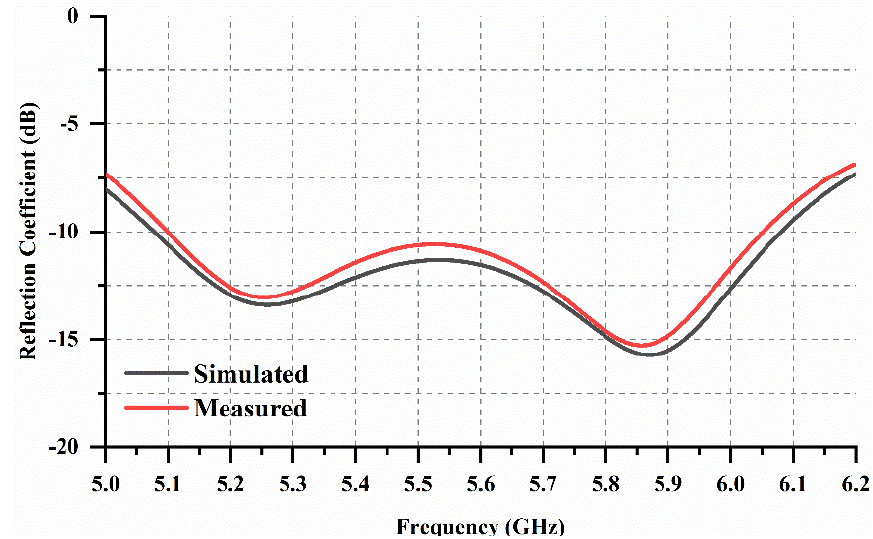
Figure 11. Simulated and measured return losses.